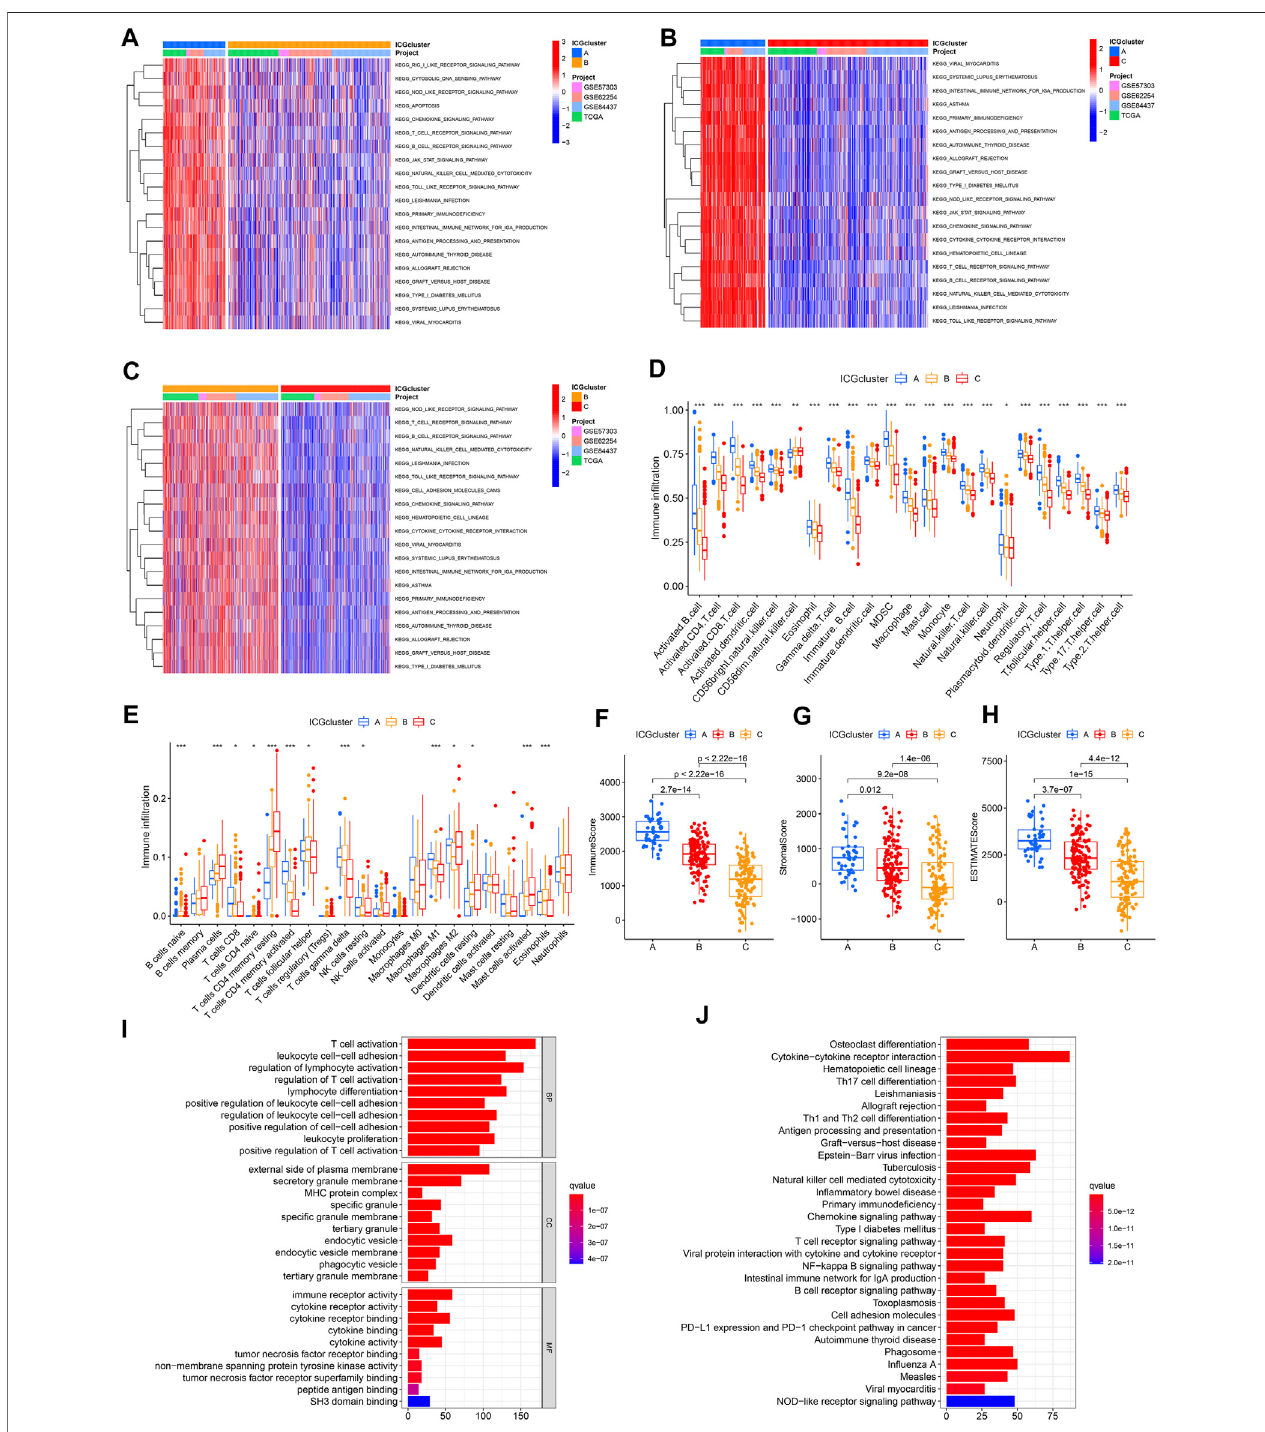
FIGURE 3 | Functional enrichment analysis of three immune checkpoint regulation patterns. (A – C) GSVA enrichment analysis showing the activation states of biological pathways in distinct immune checkpoint regulation patterns. (D) The abundance of each TME in fi ltrating cell in three immune checkpoint regulation patterns using ssGSEA. (E) The abundance of immune cell in fi ltration of GSE62254 cohort using CIBERSORT. (F – H) The contents of immune cells and stromal cells in GC samples of GSE62254 cohort using ESTIMATE. (I,J) Functional annotation for immune checkpoint-related genes using GO and KEGG enrichment analysis.